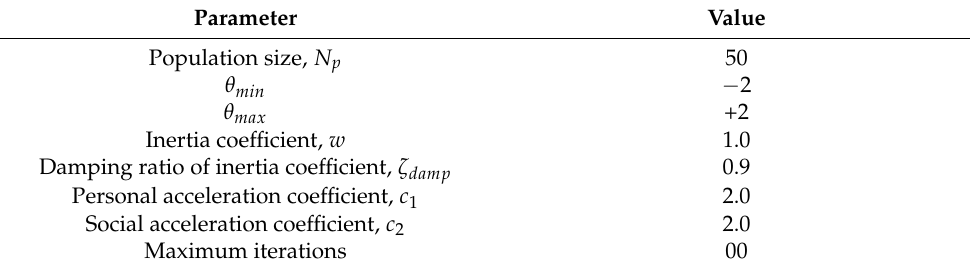
Table 1. Parameters of the PSO